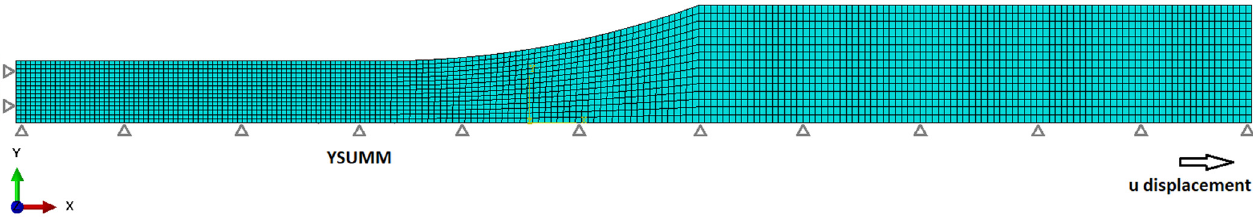
Figure 3. The FE model of the quarter dog-bone specimen.